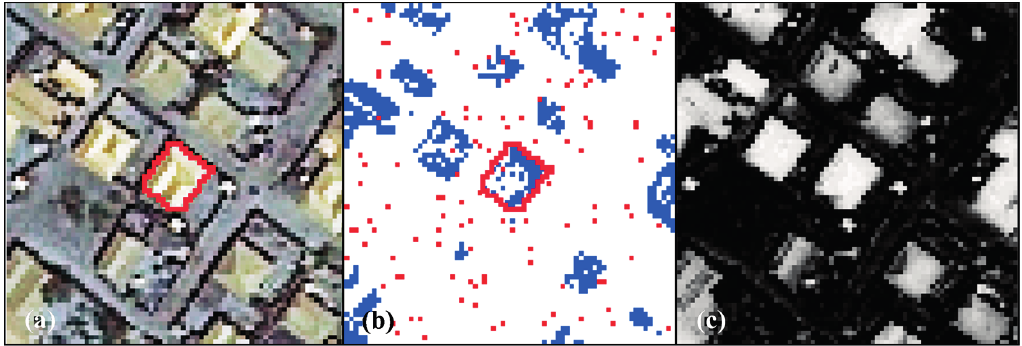
Figure 5. Image processing conducted to derive a probability image. ( a ) Illustrates a subset with a delineated reference segment; ( b ) the masking and synthetic sampling procedure and ( c ) the generated probability